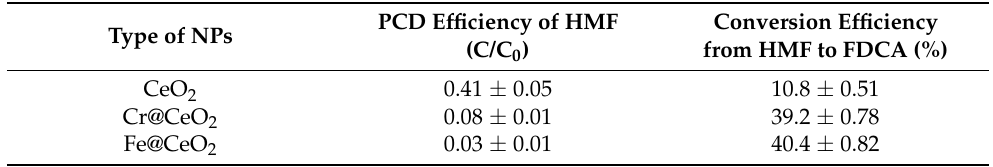
Table 2. PCD performance and FDCA conversion yields determined through the photolysis of 25 mM HMF for 24 h under UV irradiation of 365 nm wavelength in the presence of CeO 2 , Cr@CeO 2 , and Fe@CeO 2 NPs; these are the data at 24 h in Figure 3. Type of